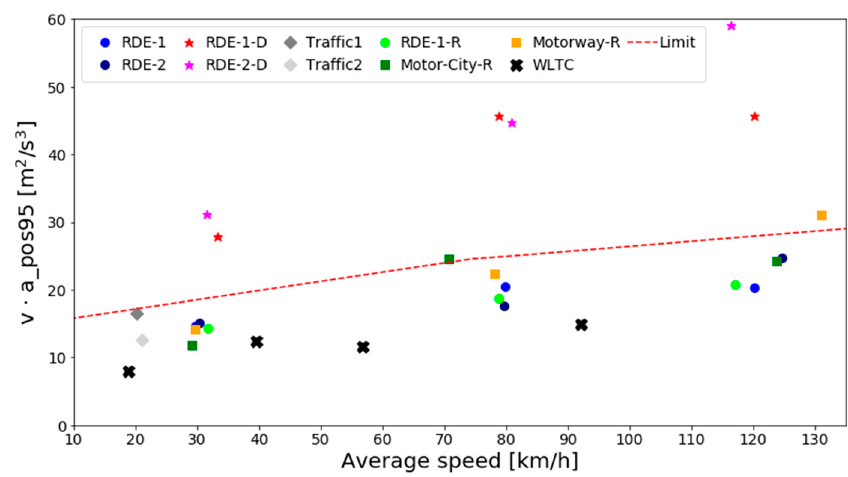
Figure A2. Overview of the driving dynamics, in terms of the 95th percentile of v × a for the laboratory and RDE tests. There are three markers per RDE test corresponding to the respective Urban/Rural/Motorway phase. Note that the Traffic tests are Urban-only tests. Tests labelled with an R at the end correspond to those where a DPF regeneration occurred. The red dotted line indicates the 95th percentile of the v × a limit, as defined for M1 vehicles in Appendix 7 of the RDE regulation. The WLTC laboratory cycle is divided into its respective phases. RDE = Real-Driving Emissions; WLTC = Worldwide harmonized Light vehicles Test Cycle.